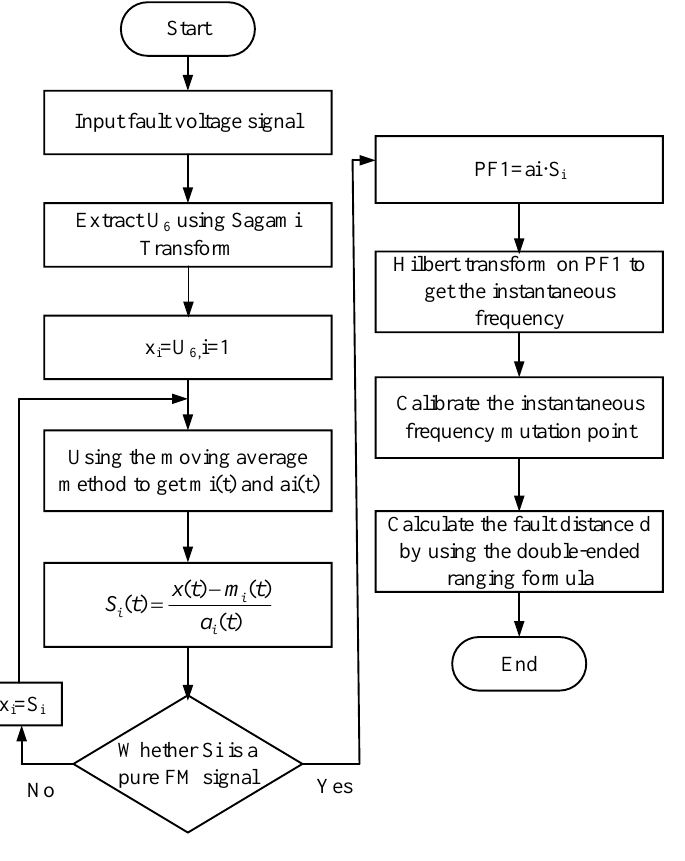
Figure 3. Ranging flowchart.